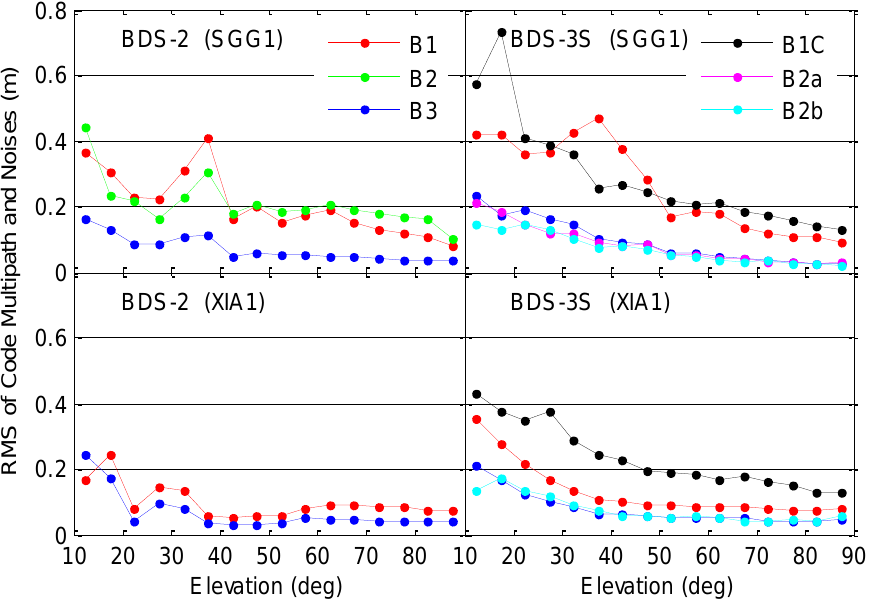
Figure 9. RMS statistics of code multipath and noises against satellite elevation angles at stations SGG1 and XIA1.